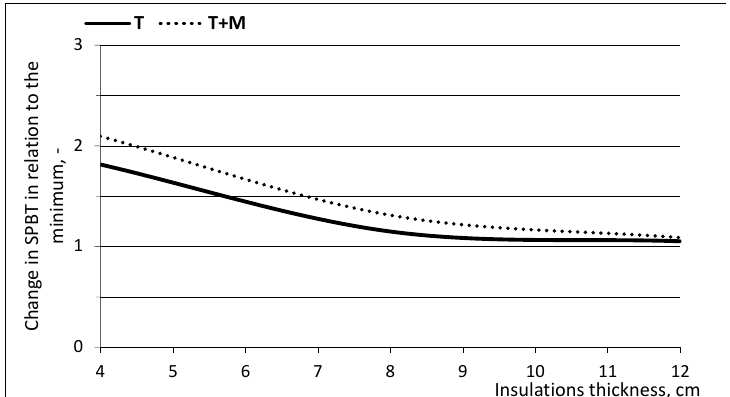
Figure 4. Change of SPBT depending on the type and thickness of internal thermo-insulation for the localization of analyzed rooms in the building for the Warsaw climate zone and external insulation made of MW, material A, one external wall.